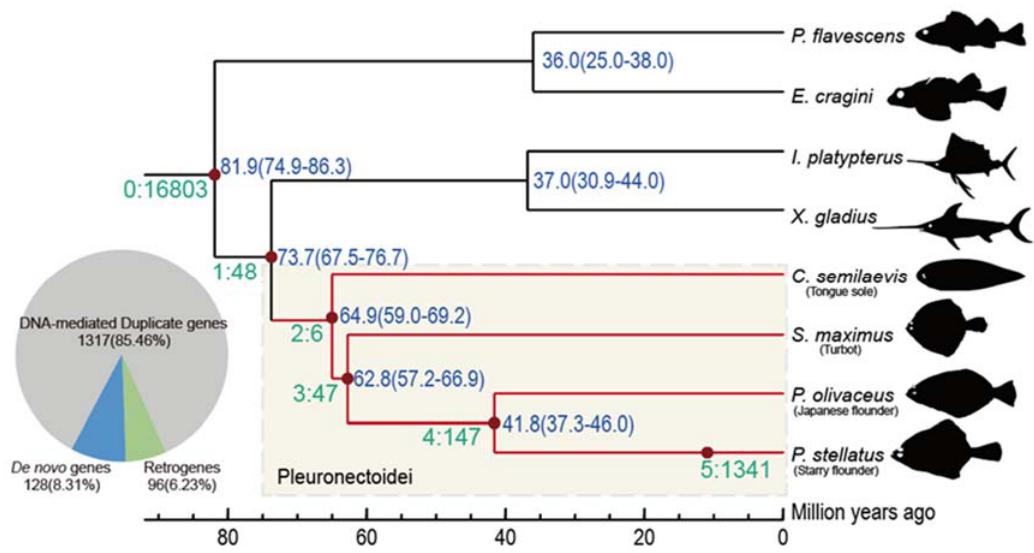
Figure 1. Branch view of the distribution of new genes. In SBP, a total of six distinct age groups (branch 0–5) were specified based on the phylogenetic context. Genes postdating P. stellatus - C. semilaevis split (branch 2–5) are referred as Pleuronectoidei-specific genes, marked with light yellow block. The number and proportion for each origin mechanism of the 1541 Pleuronectoidei-specific genes are plotted in a pie chart.